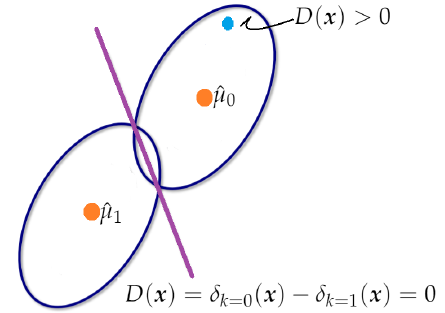
Figure 7. The picture displays two clusters (cluster 0 and cluster 1). If D ( x ) is greater than 0, the blue point is classified as cluster 0 and otherwise as cluster 1. The purple line corresponds to the boundary δ k = 1 ( x ) = of decision, D ( x ) = δ k = 0 ( x ) −